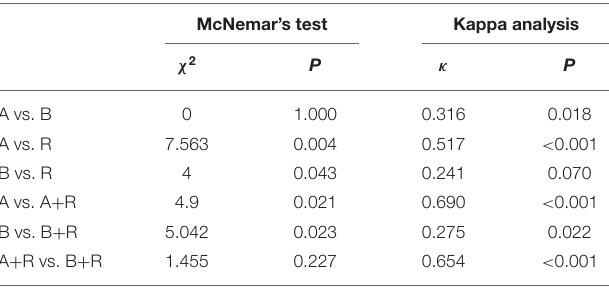
TABLE 3 | Performance comparison between radiomic predictive model and two radiologists in test